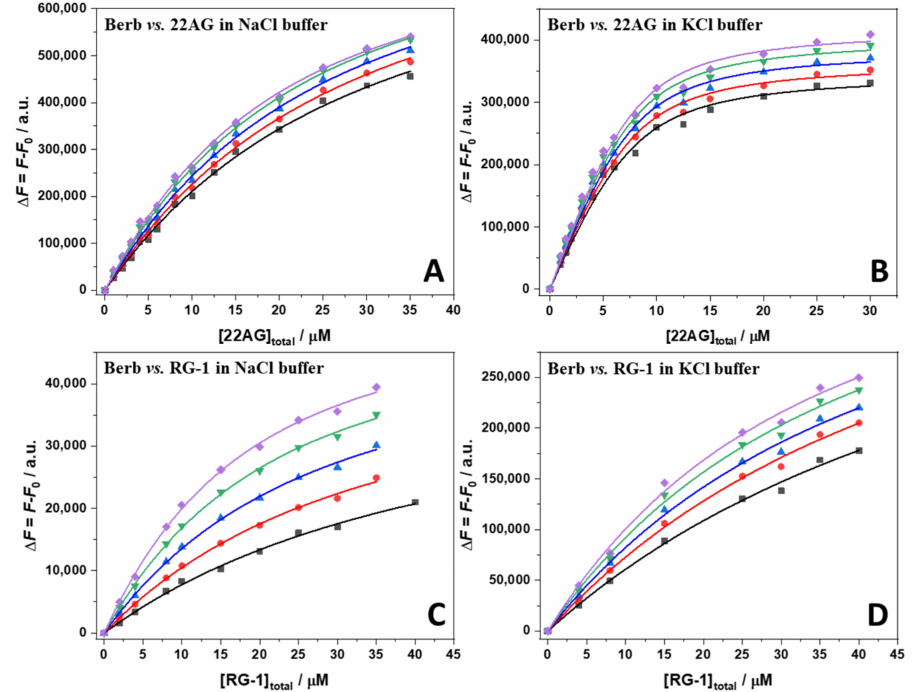
Figure 8. Binding isotherms for the Berb/22AG (panel ( A , B )) and Berb/RG-1 (panel ( C , D )) systems obtained from high pressure fluorescence spectroscopy in 30 mM Tris buffer, pH 7.4, with the addition of 100 mM NaCl or KCl at the temperature of 25 ◦ C and pressures of: 1 bar (black squares), 500 bar (red circles), 1000 bar (blue triangles), 1500 bar (green reversed triangles), and 1900 bar (violet diamonds). The berberine concentration was 15 µ M, the concentration of the G4Qs was varied between 0 µ M and 40 µ M. The berberine was excited at 443 nm, whereas the emission was collected at the maximum of emission, at 536 nm. The continuous lines represent the best fit of the experimental data according to an equivalent and independent binding sites model using the stoichiometries reported in Table